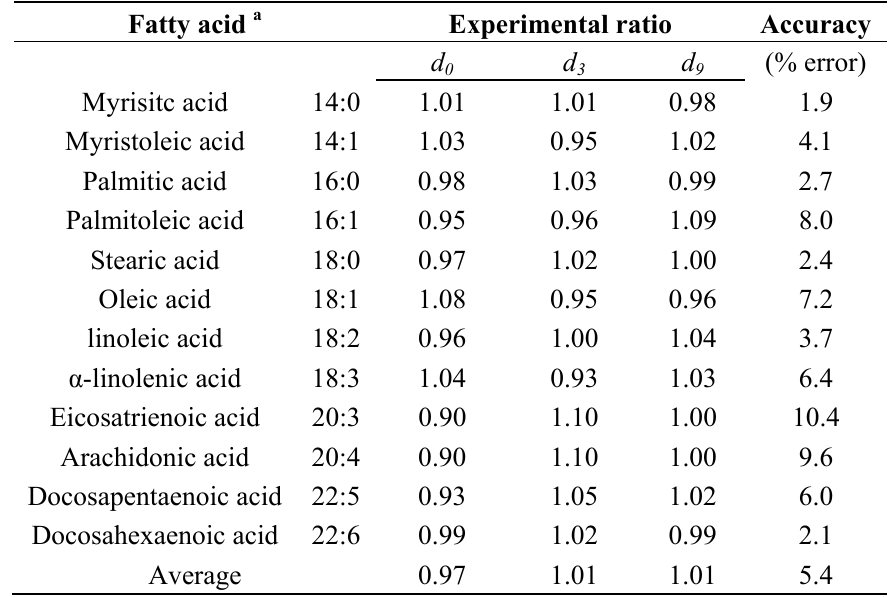
Table 1. Simulated multiplexed fatty acid analysis where the expected ratio of fatty acids was 1.00:1.00:1.00, d